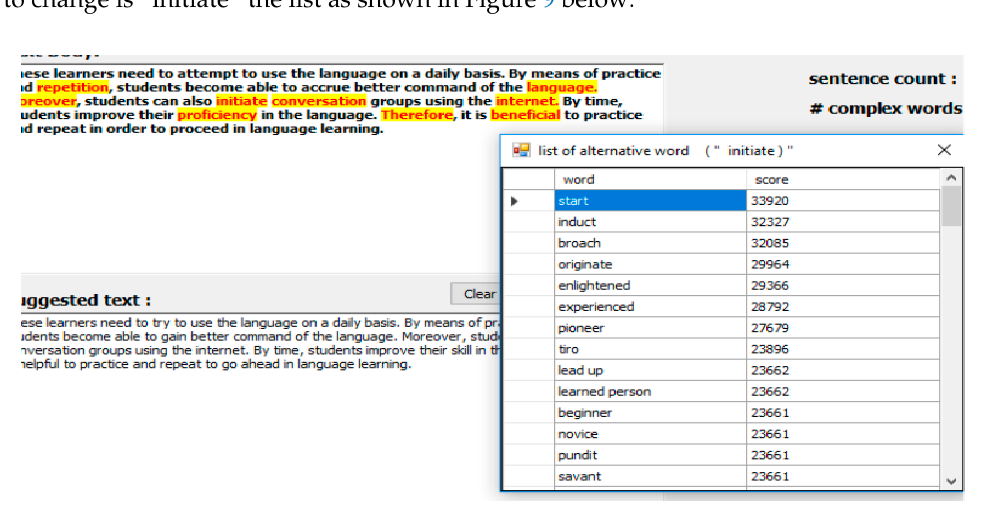
Figure 9. Alternative words for “initiate .”